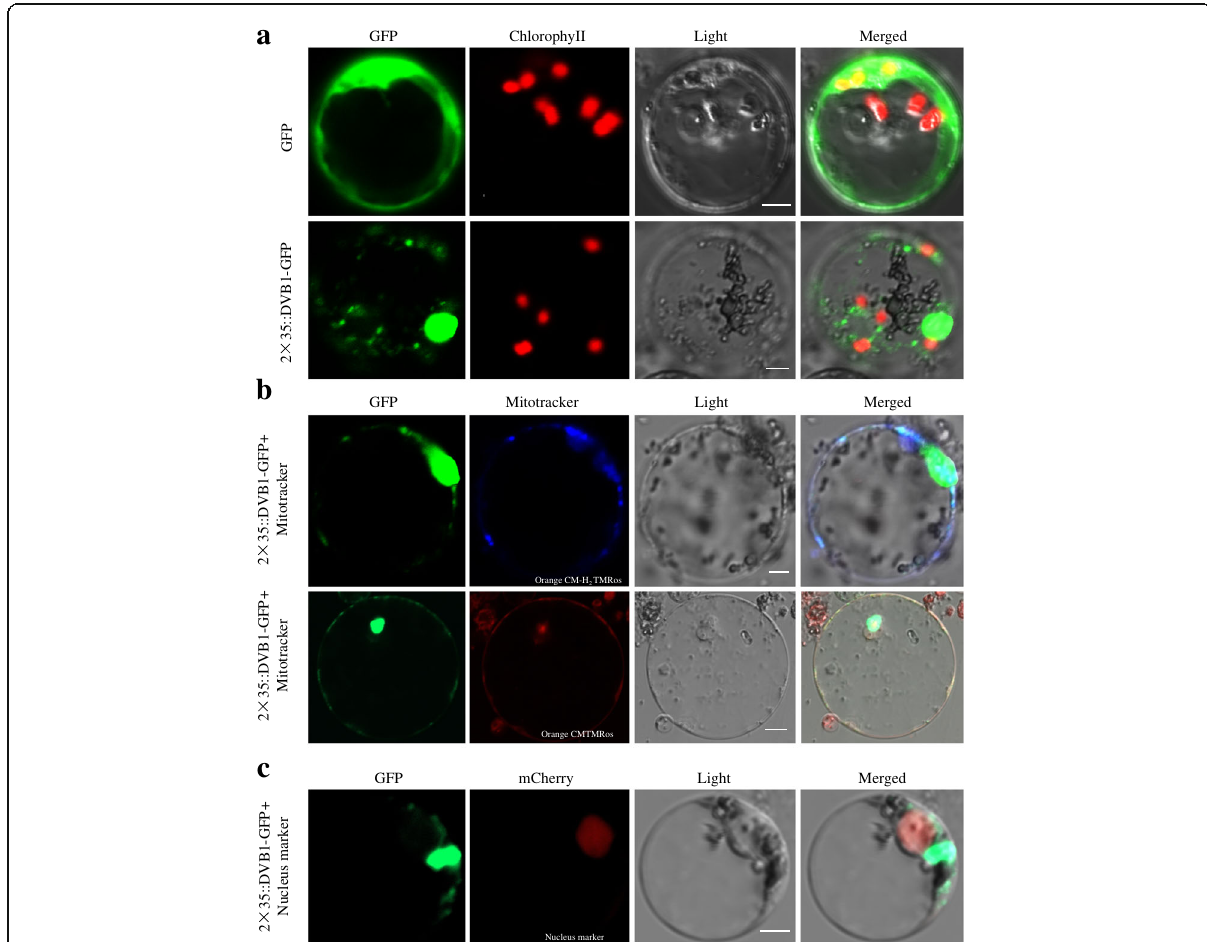
Fig. 5 Subcellular localization of DVB1 protein. a Subcellular localization of GFP and DVB1-GFP in rice protoplasts. b Subcellular localization of DVB1-GFP and MitoTracker (Orange